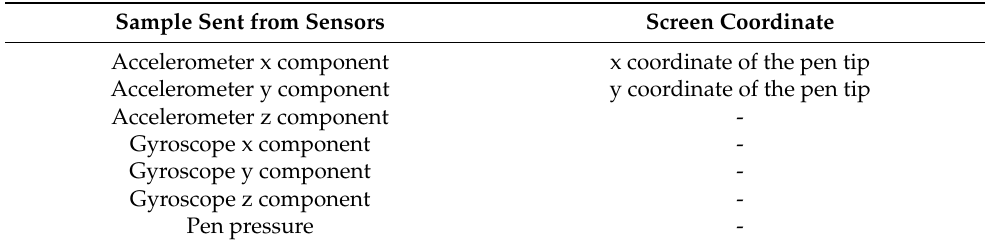
Table 1. Data received from the biometric pen and captured from screen coordinates. One sample sent from the pen contains 7 values, while the sample recorded from the screen contains 2 values.